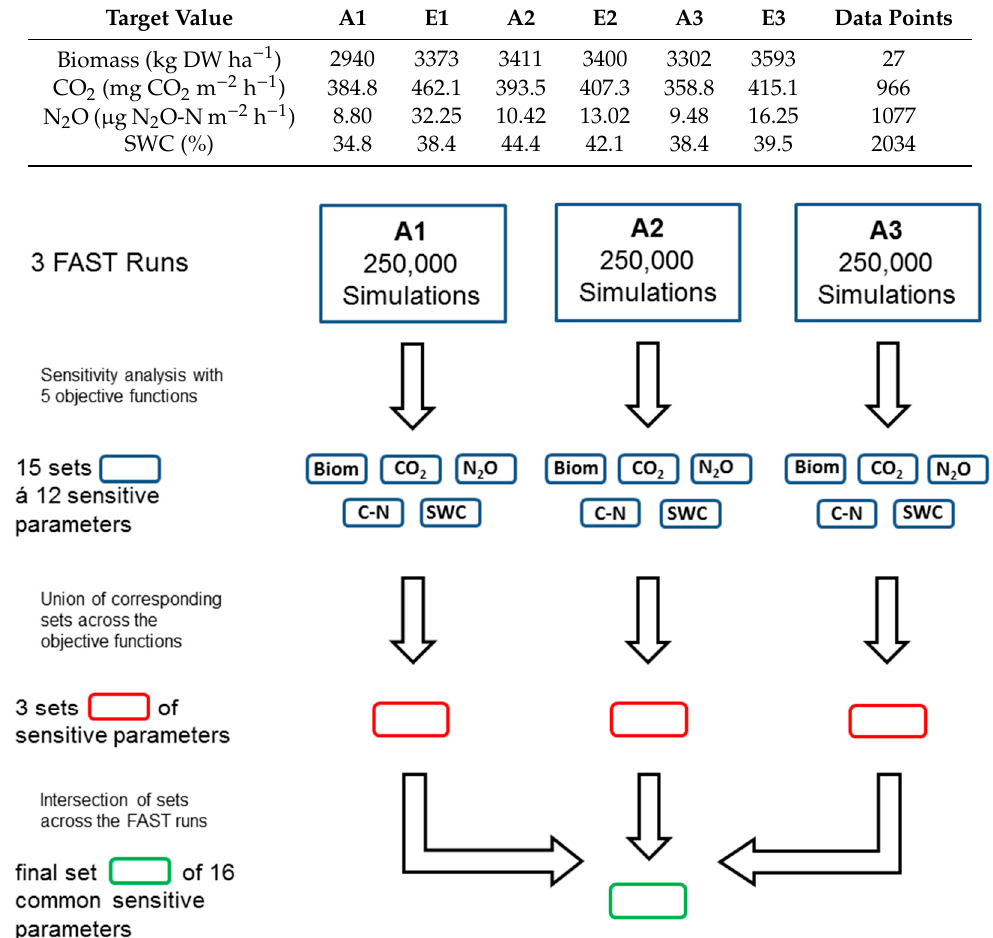
Figure A1. Sensitivity analysis diagram: calculation of the most sensitive parameters where 750,000 parameter sets were sampled in 3 FAST runs, one for each plot ( = measuring site). For each run, the 12 most sensitive parameters were calculated separately for 5 objective functions: RMSE of biomass, C-N ratio, CO 2 emissions, N 2 O emissions, and soil water content. After that, the sensitive parameters were unified within each FAST run. Finally, an intersection of the unified parameters was made among the FAST runs, creating the choice of sensitive parameters that was used for calibration.